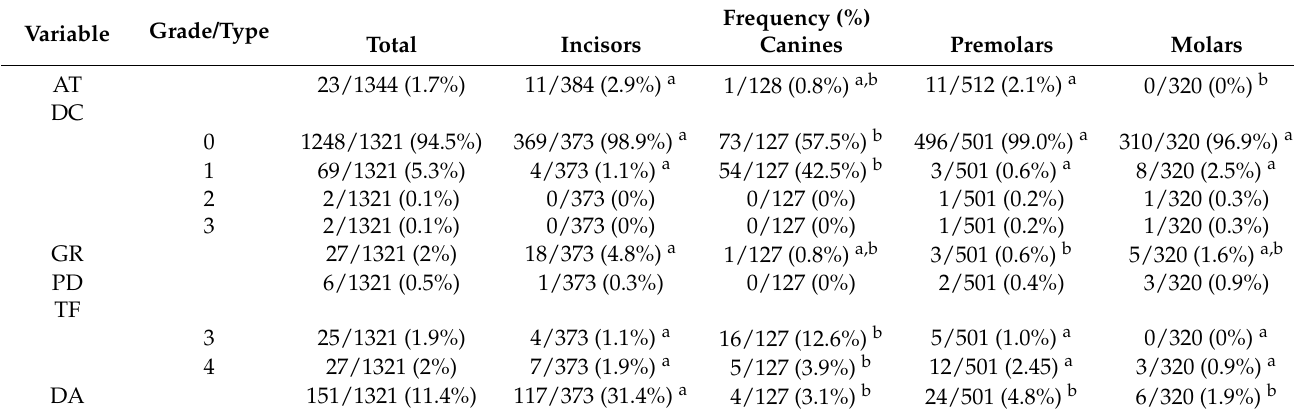
Table 3. Results obtained per type of tooth. AT: absent teeth; DC: dental calculus; GR: gingival recession; PD: periodontal disease; TF: tooth fracture; DA: dental attrition. a,b Different superscript letters within rows indicate statistically significant differences among teeth ( p <